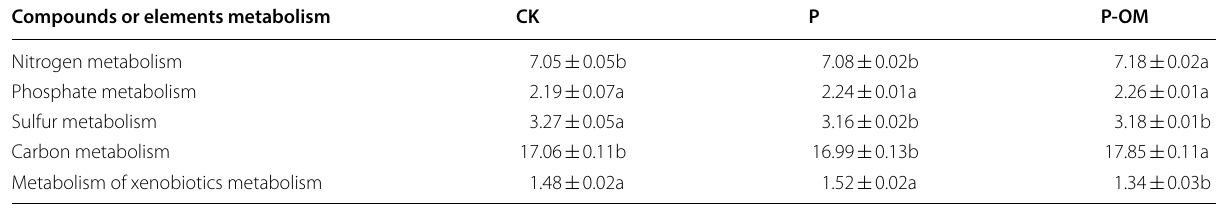
Table 4 Relative abundance of PICRUSt-predicted reads annotated to genes for different compounds or elements metabolism